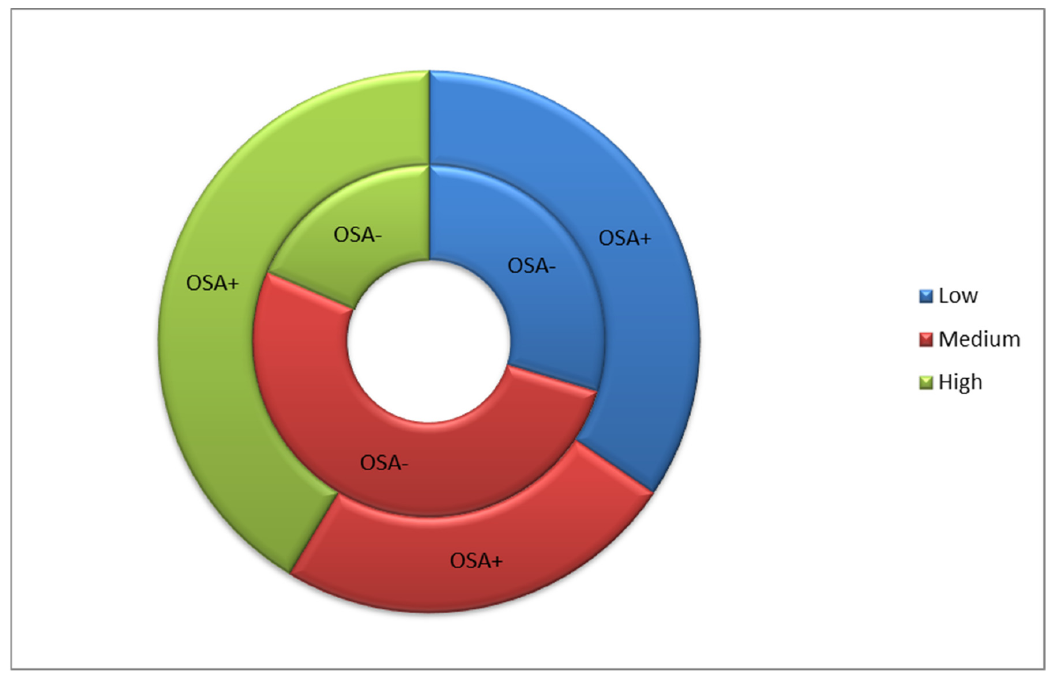
Figure 1. Fetuin-A level in OSA+ and OSA − groups.